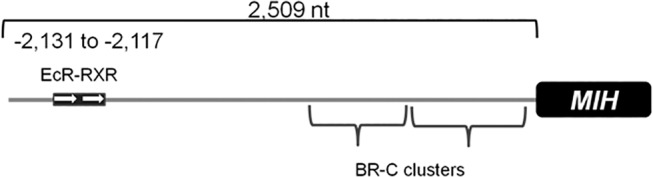
A schematic diagram of upstream promoter region of CasMIH gene (GenBank Accession no.KJ813010) containing putative DNA binding sites. The putative binding sites of ecdysteroid-responsive factors are predicted (http://consite.genereg.net/). White arrows represent a direct repeat of AGGTCA motifs for EcR-RXR binding. The binding site of broad complex (BR-C) is located in clusters.